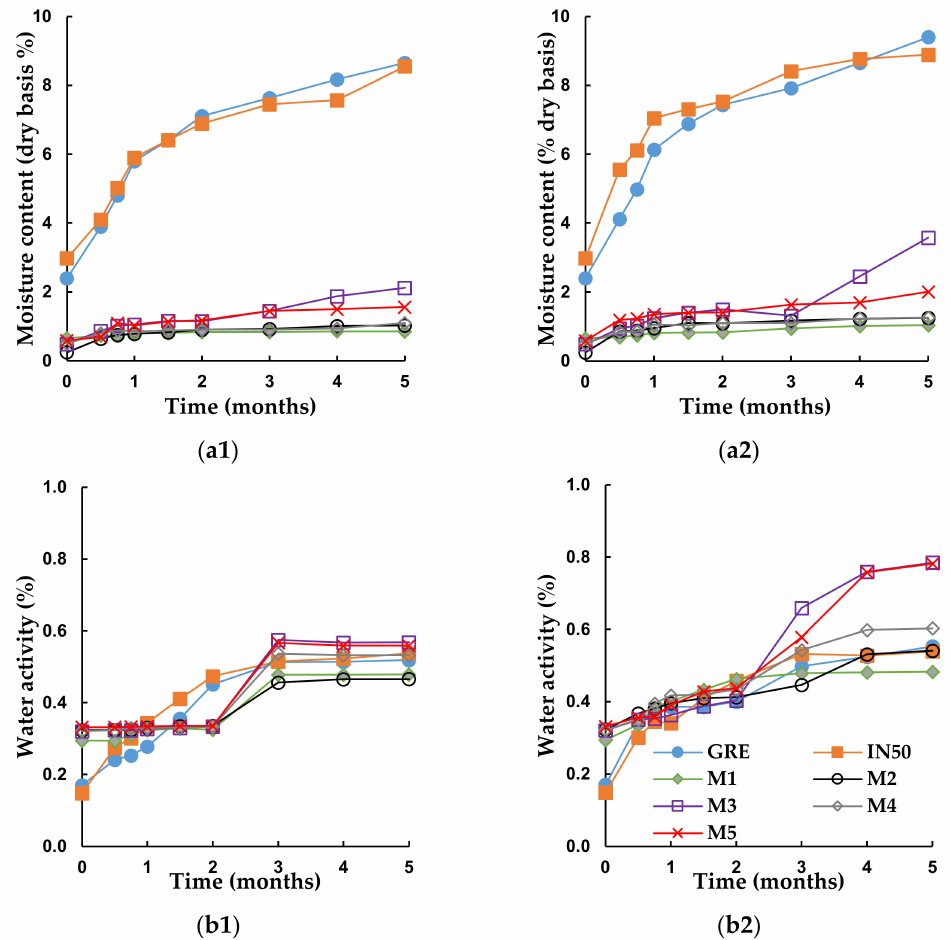
Figure 4. Moisture content ( a ) and water activity ( b ) of green rooibos extract powder and powder mixtures: green rooibos extract (GRE), GRE microencapsulated with inulin in 1:1 ratio (m/m) (IN50), M1 (IN50 and sucrose), M2 (IN50 and xylitol), M3 (IN50, xylitol, and citric acid), M4 (IN50, xylitol, and ascorbic acid) and M5 (IN50, xylitol, ascorbic acid, and citric acid), during storage at ( 1, a1 and b1 ) 30 ◦ C/65% RH and ( 2, a2 and b2 ) 40 ◦ C/65% RH for 5 months in semi-permeable